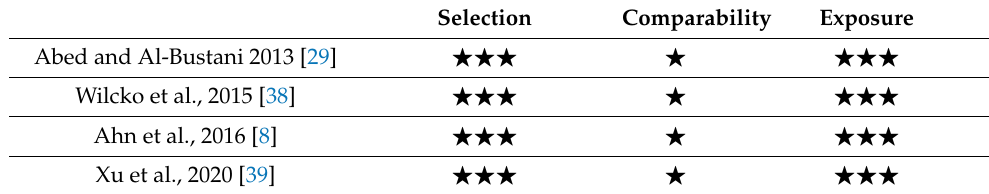
Table A2. Newcastle–Ottawa Quality Assessment Scale of included case-control